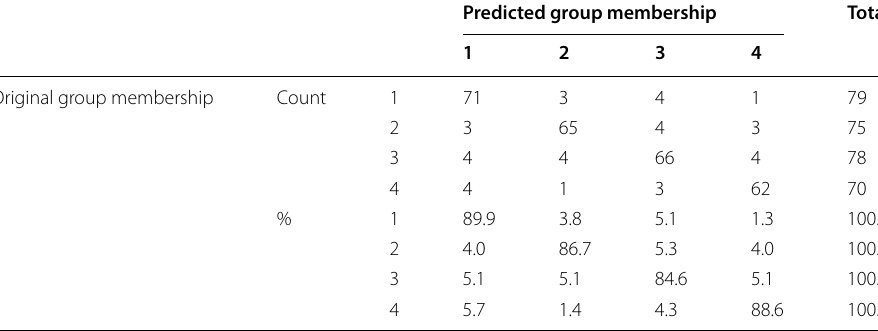
Overall 87.4% of the originally grouped cases were correctly classified